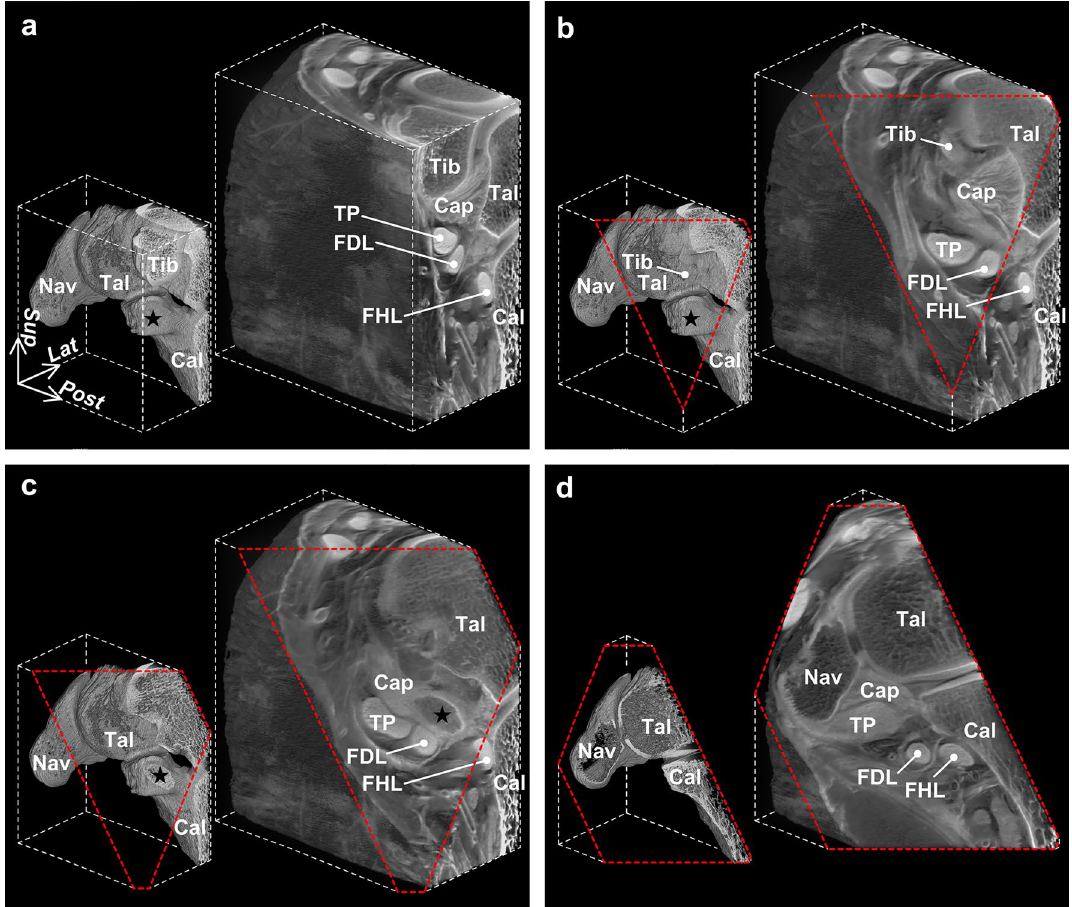
Figure 1. Three-dimensional reconstruction images of the ankle joint capsule complex with flexor tendons. Posteromedial aspect of the right foot. Each view direction of the image on the lower left side corresponds to those on the right side. Red dotted lines indicate the image cutting planes. Medial part ( a , b ), extending distally from the tibia (Tib), and plantar part ( c , d ), between the sustentaculum tali (star) and navicular (Nav), of the ankle joint capsule (Cap) form a complex with the tendinous sheath of the tibialis posterior (TP) and flexor digitorum longus (FDL). Cal calcaneus, FHL flexor hallucis longus, Tal talus, Lat lateral, Post posterior, Sup